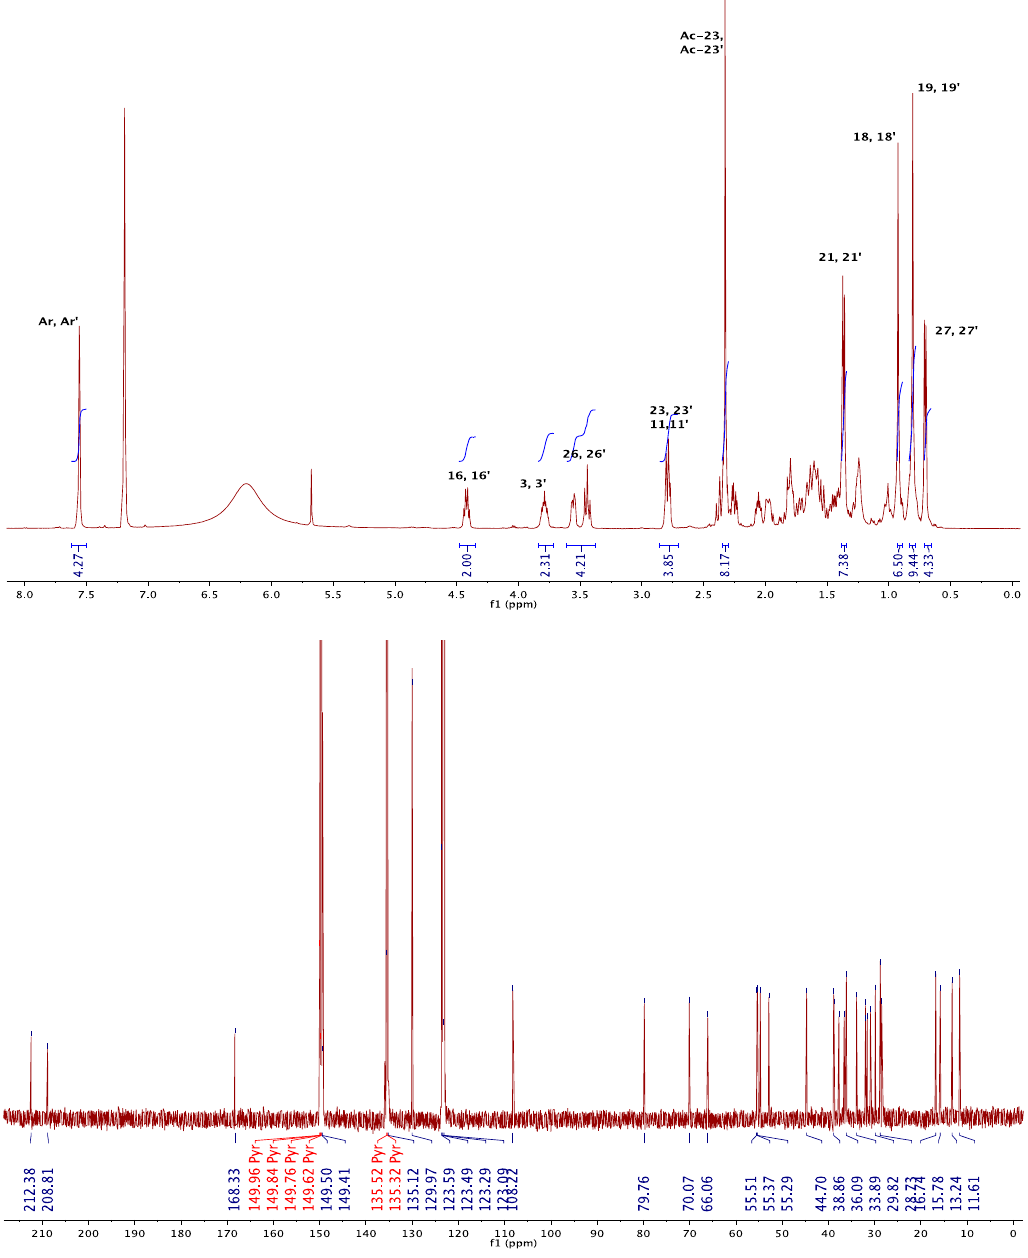
Figure 4. 1 H-NMR spectrum at 500 MHz in pyridine- d 5 of 10b (top); 13 C-NMR at 125 MHz in pyridine- d 5 of 10b (bottom).